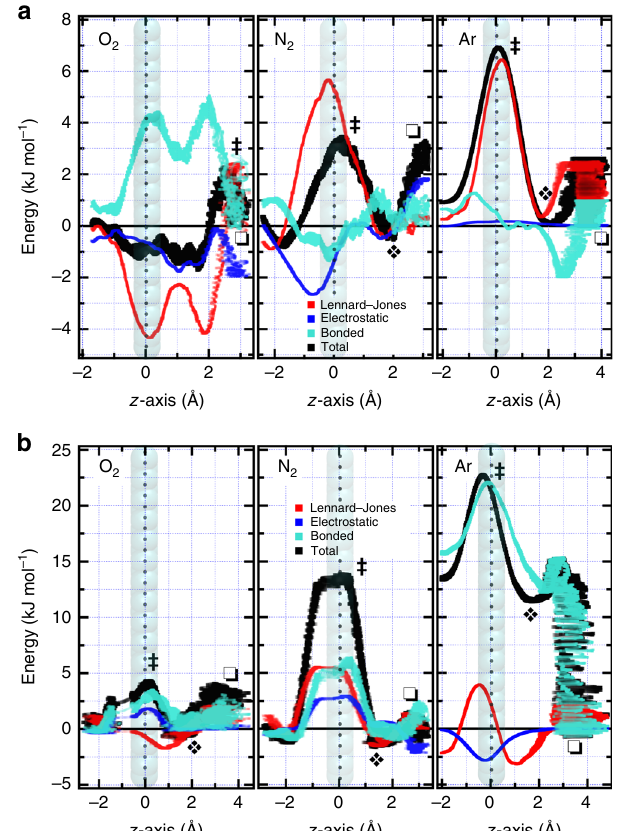
Fig. 2 Enthalpy contributions to permeation through nanowindows. a , b Permeation energy barriers of O 2 (90 K), N 2 (77 K), and Ar (87 K) through NW-3.30 a and NW-2.97 b . The z -axis is perpendicular to the graphene layer, located at z = 0. Total energy (black line) sums the contributions from Lennard – Jones (red), electrostatic (blue), and bonded interactions (turquoise). Bonded interaction energy considers bonds, angles, dihedrals, and impropers. Square, diamond, and double dagger symbols represent adsorption on the basal plane, adsorption on top of the nanowindow, and a high-energy state across the graphene plane,